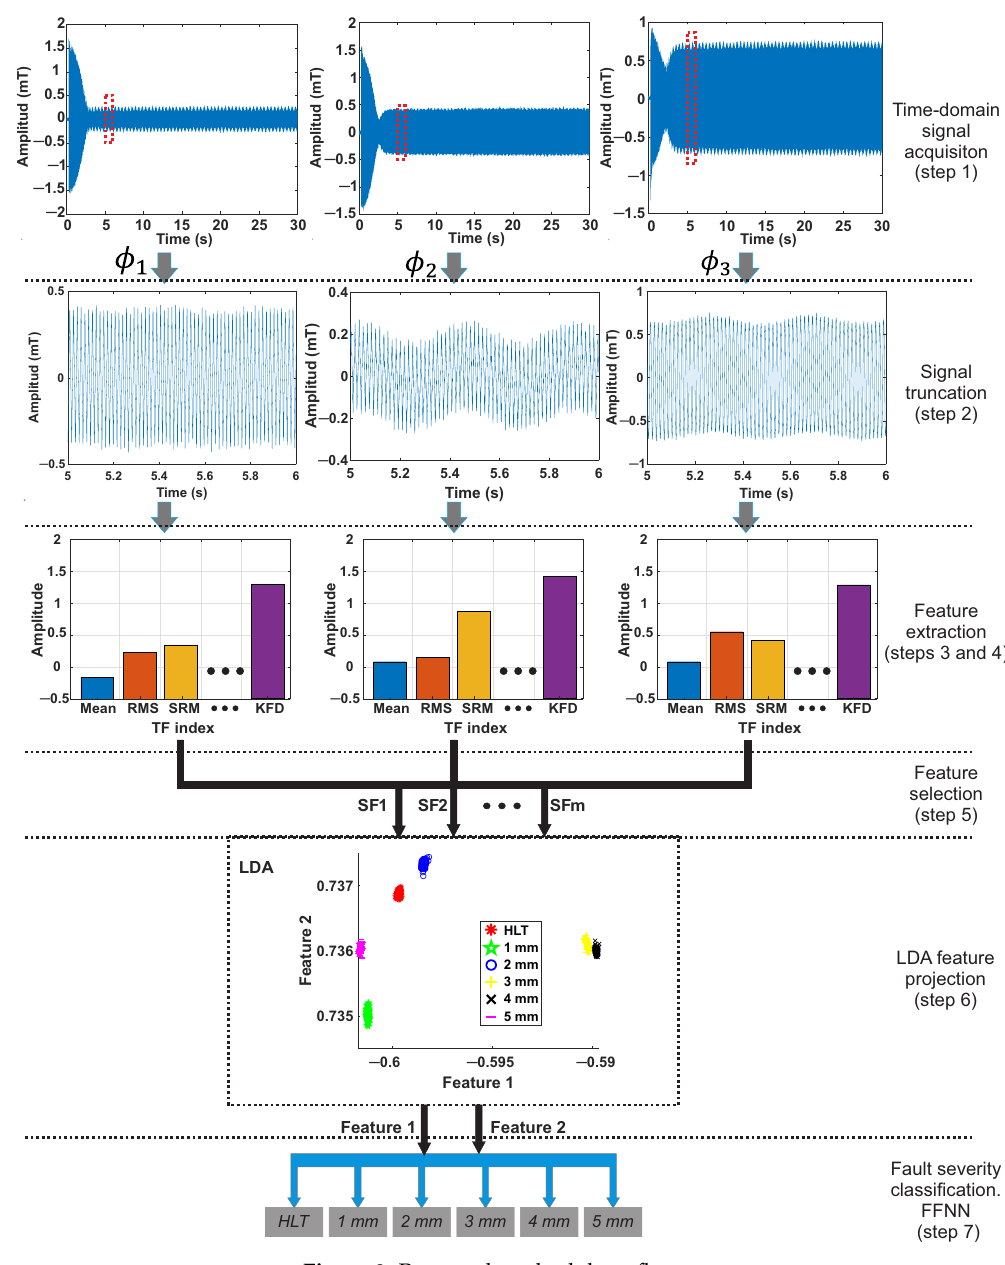
Figure 3. Proposed methodology